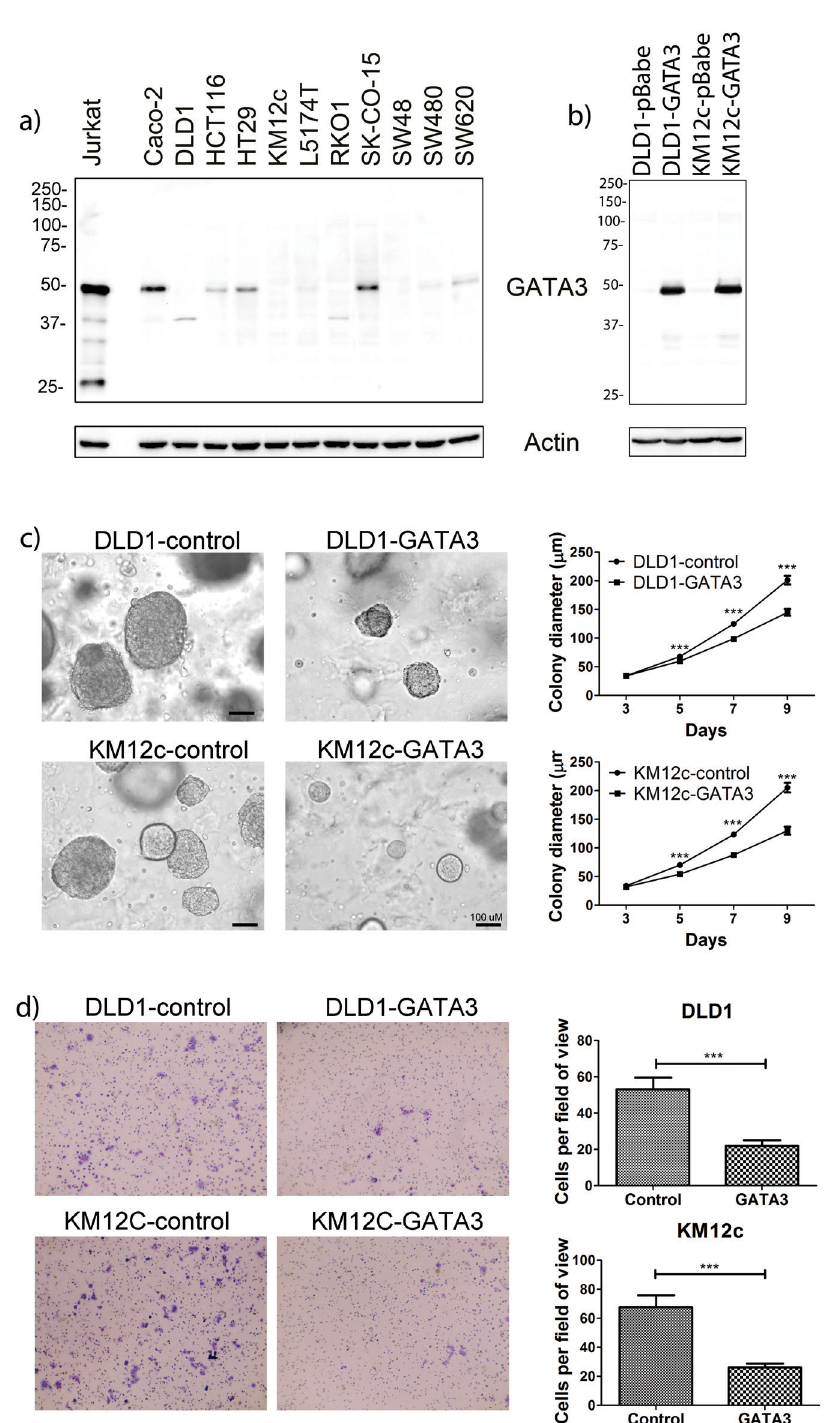
Figure 5. GATA3 expression affects CRC aggressiveness. a ) Representative Western blot (of 2 blots) showing that GATA3 is expressed in a subset of CRC cell lines. Jurkat is a T-cell line and used as a positive control. Higher expression is seen in the more differentiated cell lines Caco-2, HT-29, and SK-CO-15. b ) Western blot showing engineered expression of GATA3 in DLD1 and KM12c CRC cell lines. pBabe is an empty vector control. c ) Colony growth of engineered CRC cell lines in 3D Matrigel. Left: Representative images from day 9. Right: Growth curves. Data were gathered from duplicate wells from 3 independent experiments. The mean is plotted and error bars represent 95% CI. d ) Invasion of CRC cell lines across Transwell filters. Left: Representative images of the bottom of Transwell filters after 48 hours invasion. Right: Quantitation of invaded cells/field. Data from five random fields per filter x triplicate filters for each of 3 independent experiments. Error bars represent +/- SEM.